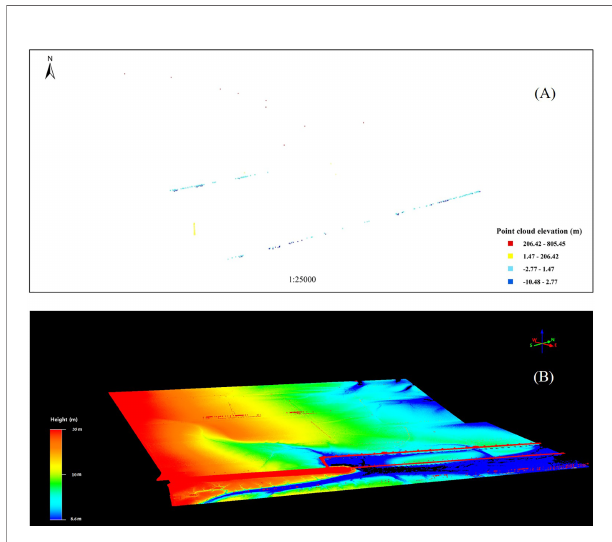
FIGURE 8 | (A) The removed gross error points; (B) The denoised point cloud